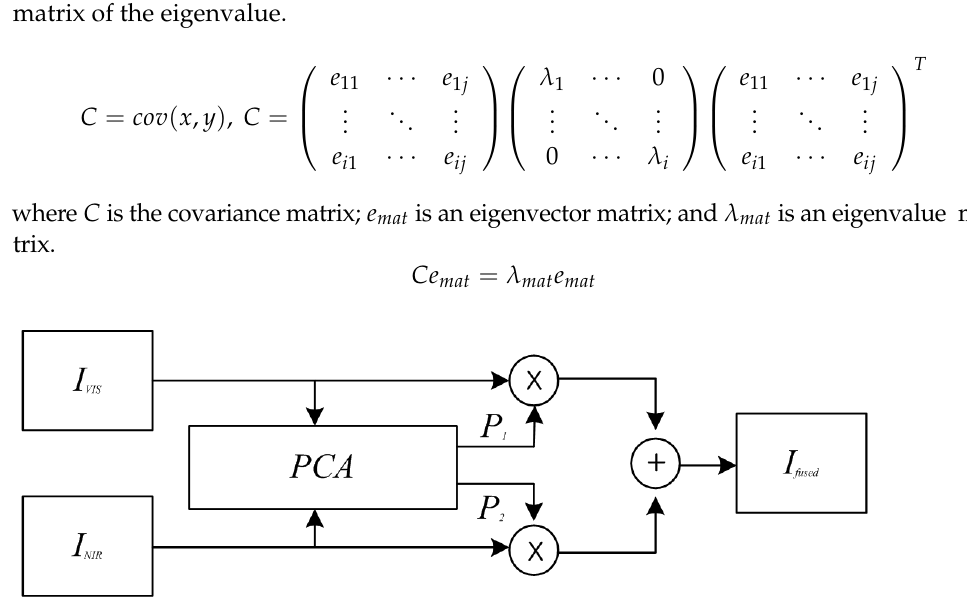
Figure 1. Principal component analysis fusion block diagram. Equations (1) and (2) can be used to calculate the eigenvalues and the corresponding eigenvectors. A 2 × 2 matrix of each eigenvector and eigenvalue matrix is calculated in the image PCA fusion algorithm. The biggest eigenvalue and the corresponding eigen- vectors are used for the PCA weight calculation. The normalize eigenvectors and these values are the optimal weight for synthesizing the visible and NIR images, as shown in Equations (3) and